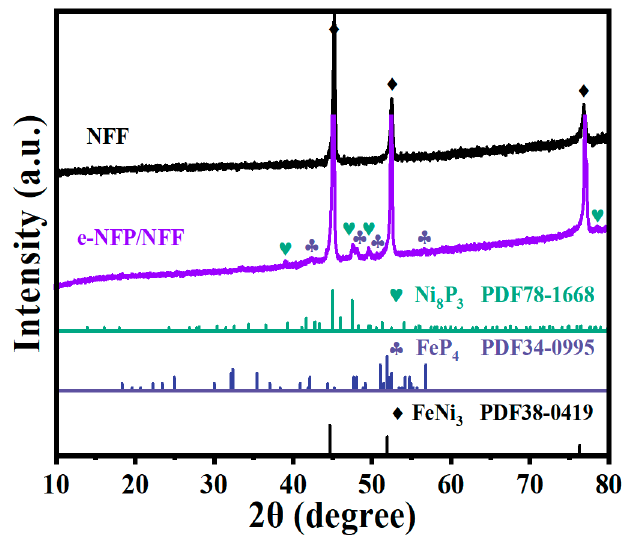
Figure 4. XRD patterns of NFF and e-NFP/NFF.